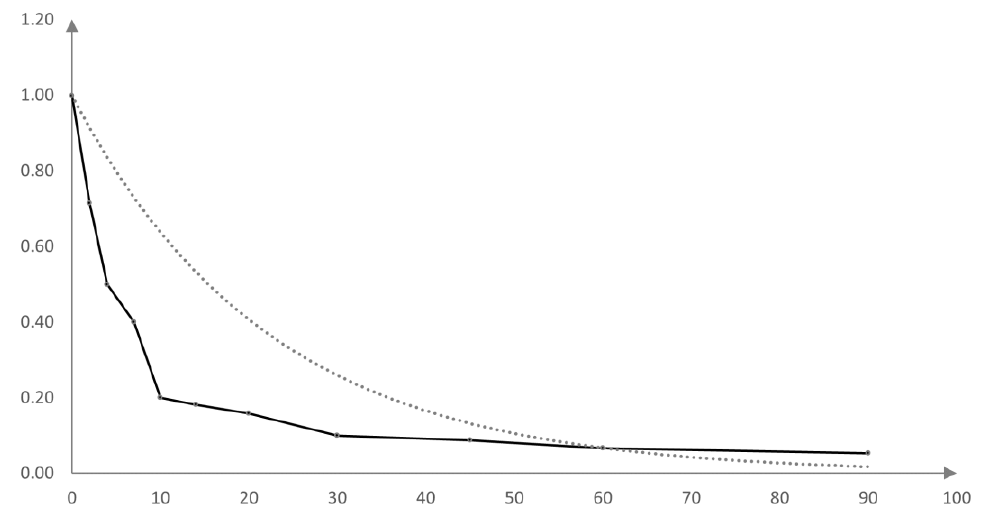
Figure 4. Empirical and normative functions.